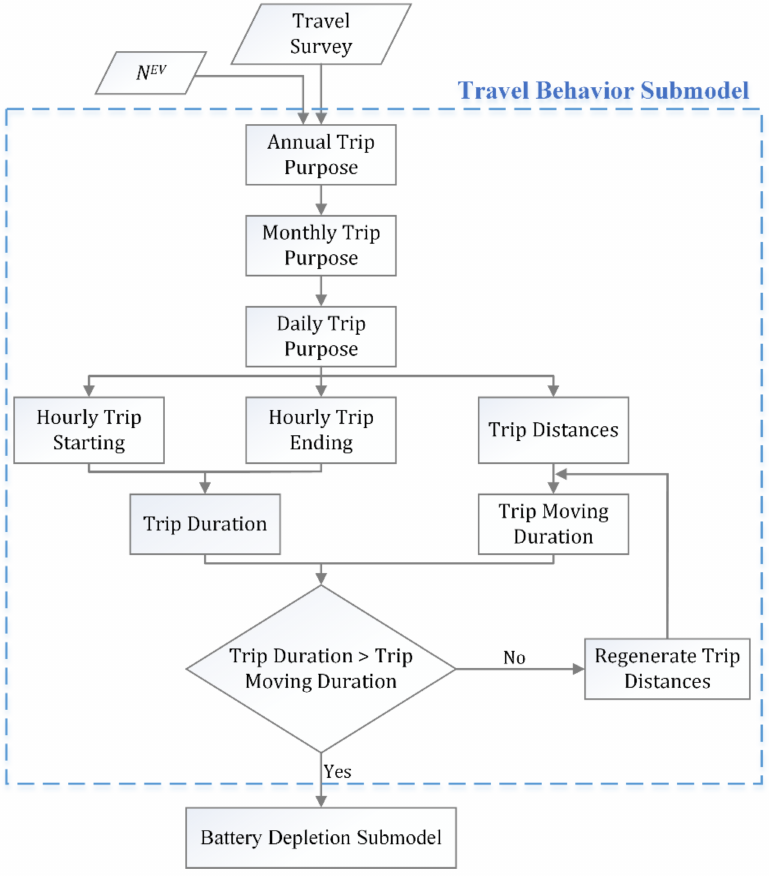
Figure 1. Proposed travel behavior submodel flow